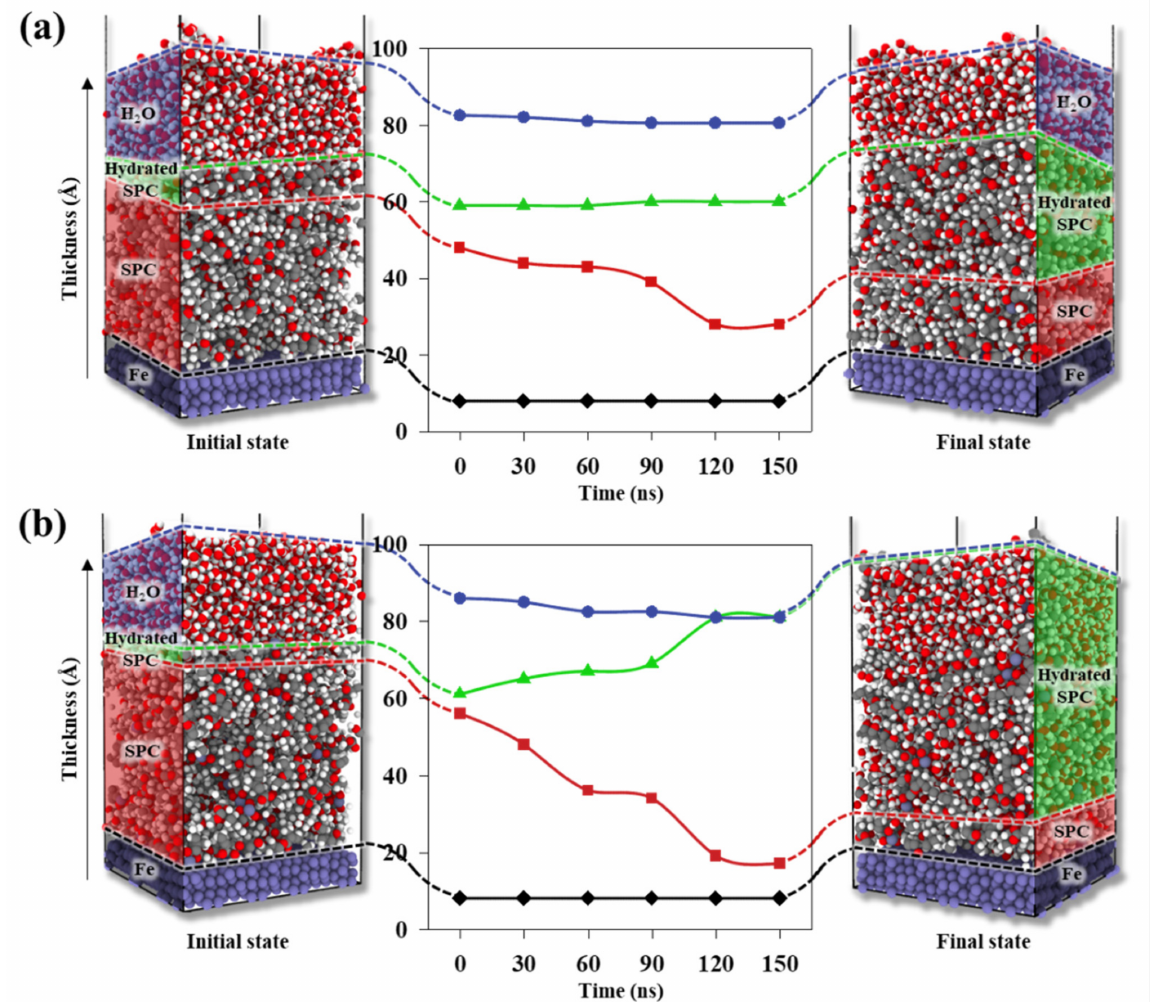
Figure 5. Snapshots of initial and final equilibrated structures of ( a ) Z2 and ( b ) Z16 with H 2 O molecules on Fe slabs. The regions (Fe, SPC, hydrated SPC, and H 2 O) are distinguished by the permeation of H 2 O molecules into SPC over time. White, gray, red, navy blue, and dark purple correspond to hydrogen, carbon, oxygen, zinc, and iron,